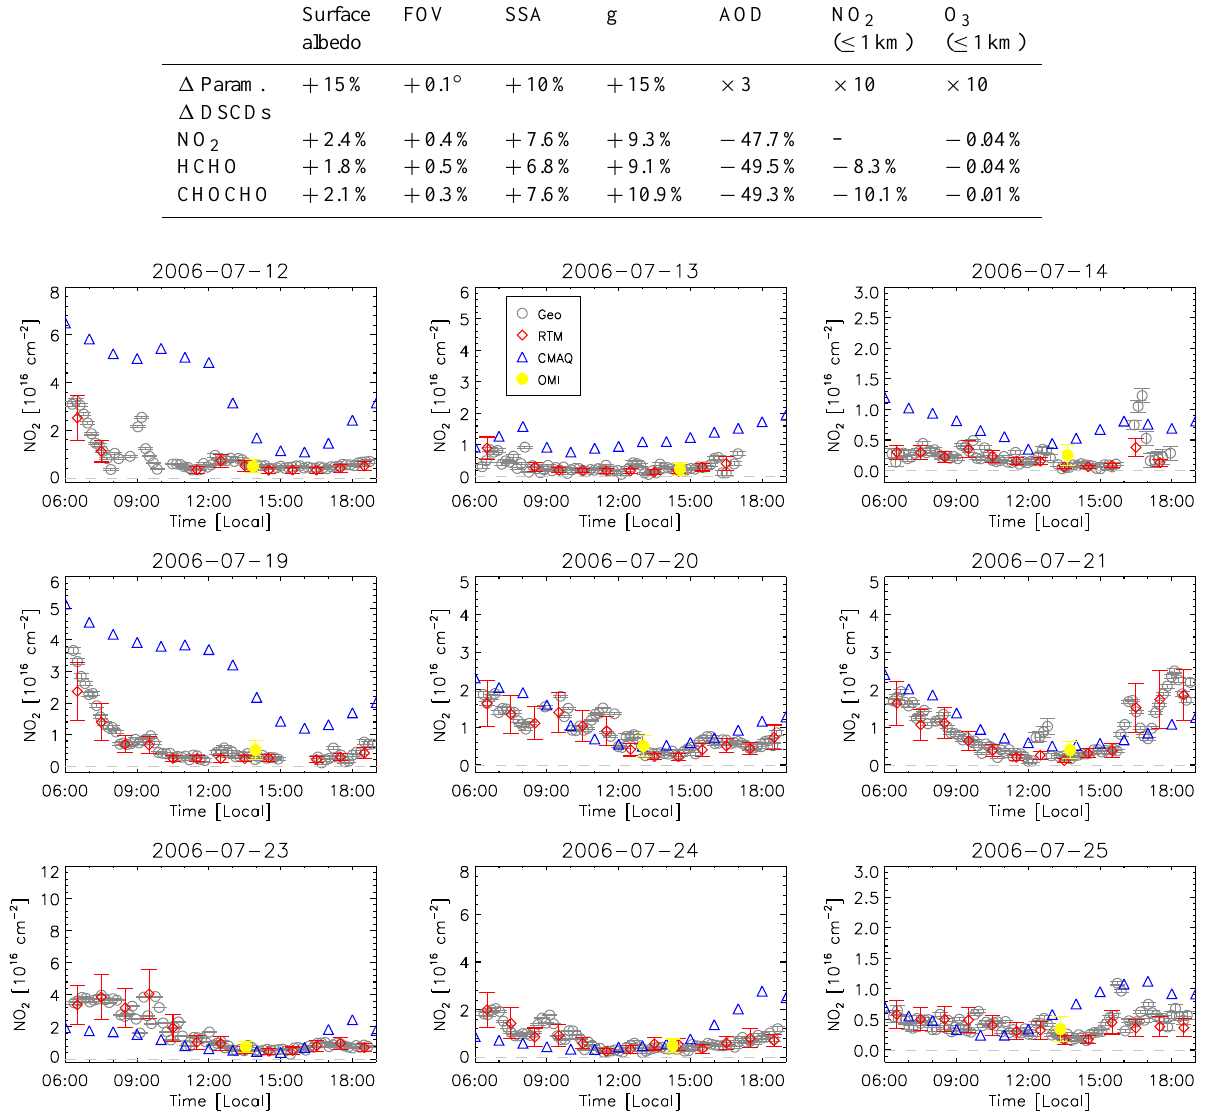
Fig. 3. Time series of NO 2 vertical column densities (VCDs) on the 9 cloud-free days during the PRIDE-PRD2006 campaign. The grey circles represent NO 2 VCDs calculated by the geometric approach (i.e. Eq.1), the red diamonds refer to NO 2 VCDs derived from the NO 2 vertical distribution retrieval (i.e. Fig. 2), the blue triangles are NO 2 VCDs calculated by the CMAQ model, and the yellow dots are NO 2 VCDs observed by OMI from